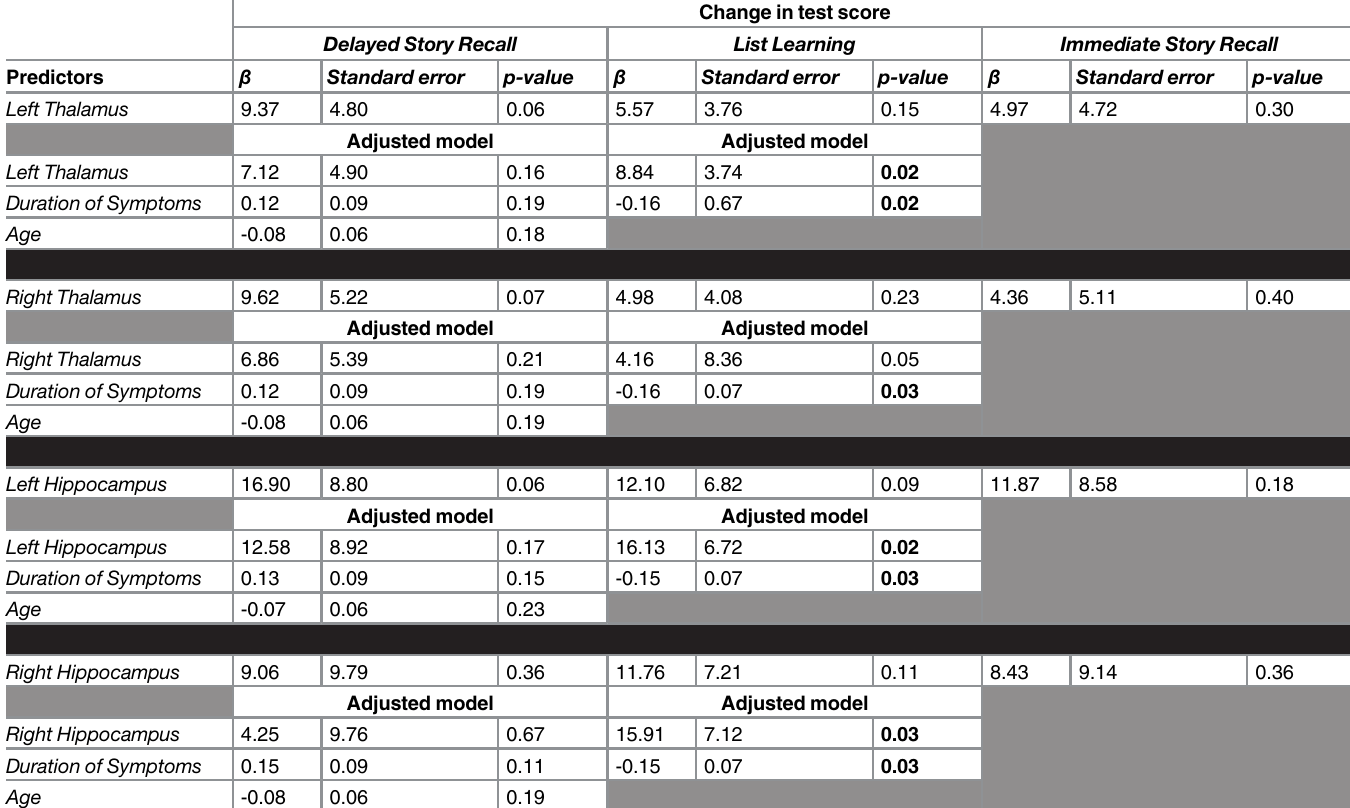
Table 3. Linear modelling of change in test scores with volumetric and clinical data.